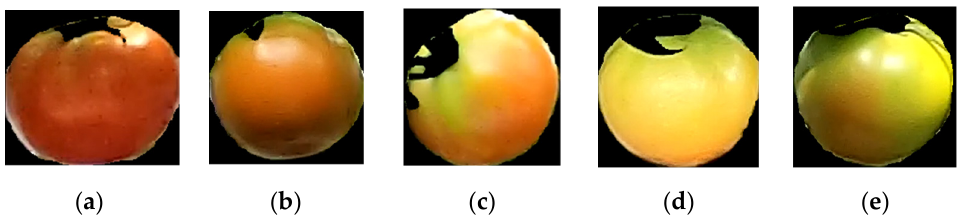
Figure 4. Classification by experienced tomato farmers. ( a ) Current Day, ( b ) One Day, ( c ) Two Days,